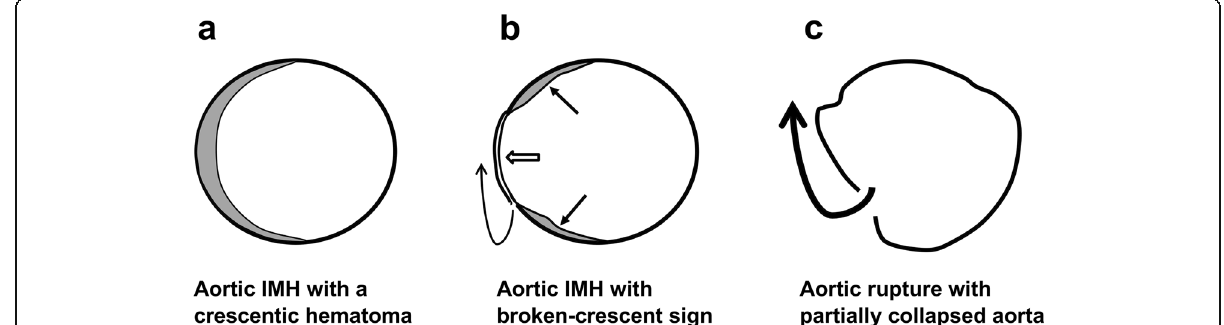
Fig. 5 Sketch shows the postulation of the development of broken-crescent sign in CT. a Acute aortic IMH with typical hyper-attenuating crescentic hematoma along the aorta on axial CT. b Partial aortic adventitial tear with outward seepage of the hematoma (curve arrow), leading to a broken-crescent configuration (arrows). Focal out-bulging (open arrow) of the residual inner aortic wall results in temporary sealing of the underlying adventitial defect. c Rupture of the aorta through the weakened residual inner aortic wall (curve arrow) with partially collapsed